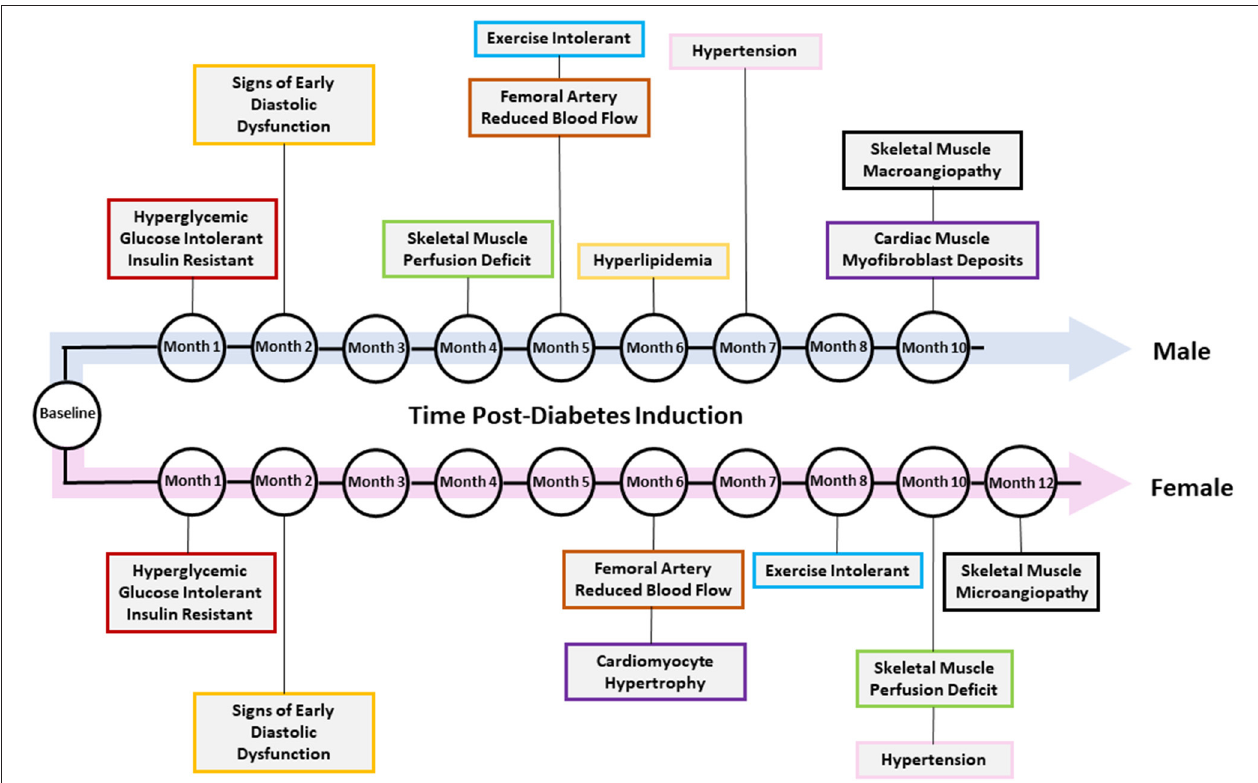
FIGURE 10 | Temporal presentation of signs and symptoms of diabetic cardiomyopathy. The key changes in vascular function, exercise tolerance, cardiac function, and other heart failure-related biomarkers are shown for diabetic male and female rats. Note that not all changes were present in both sexes.